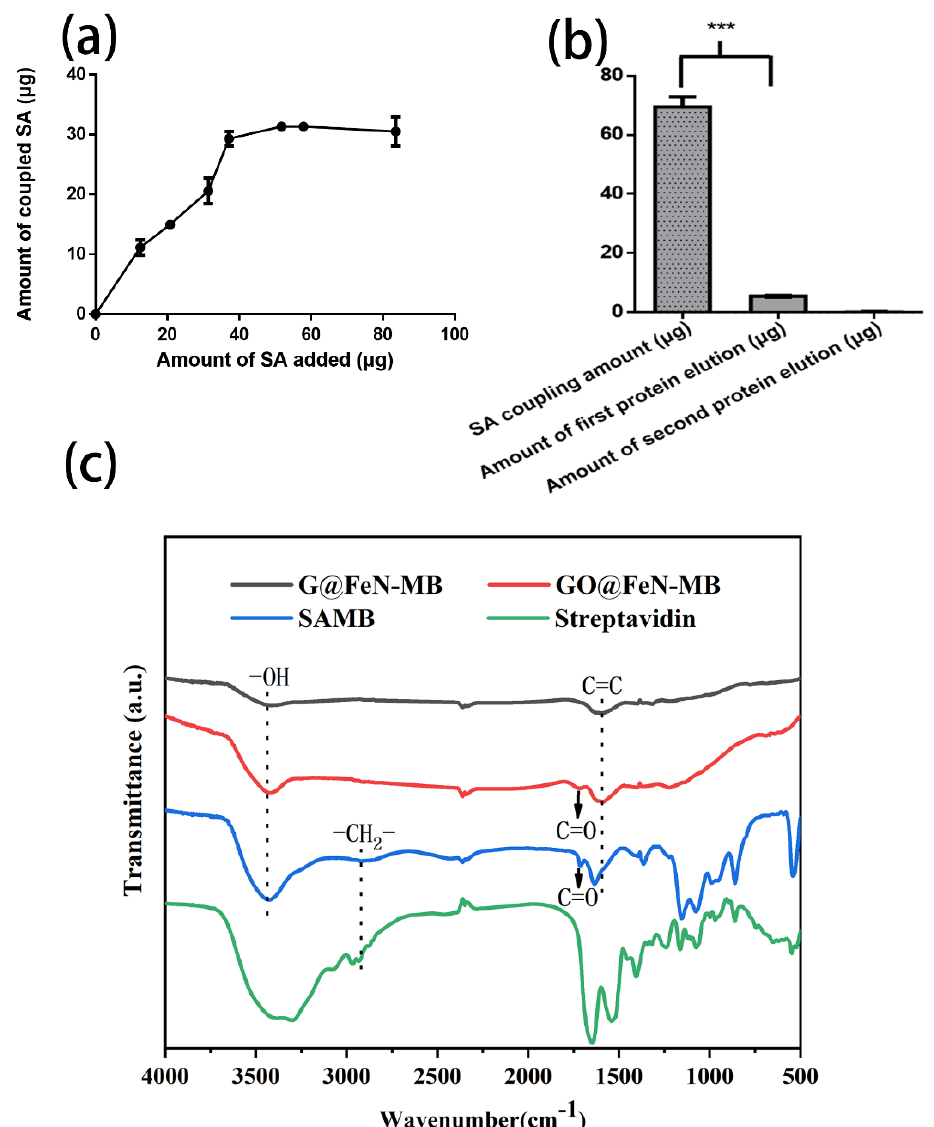
Figure 4. Conjugation effect of streptavidin: ( a ) Discounted graph of the relationship between the amount of SA coupling and the amount of SA added; ( b ) The elution amount of SA (*** p < 0.001); ( c ) FTIR of G@FeN-MB, GO@FeN-MB, SAMBs, and streptavidin.